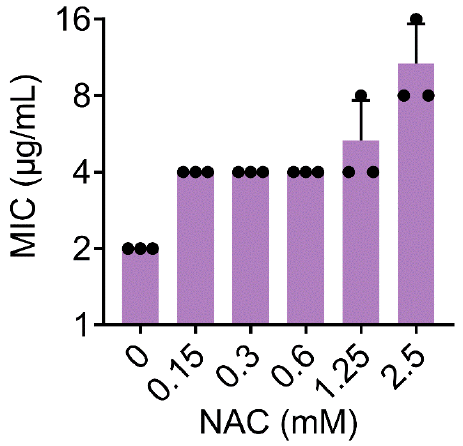
Figure 7. ROS scavenger NAC abolishes the antibacterial activity of WRK-12. MIC values of WRK-12 against E. coli 1F28 in the presence of increasing concentrations of NAC ( N -acetylcysteine) were determined. Data were presented as mean ± SD from three independent experiments.